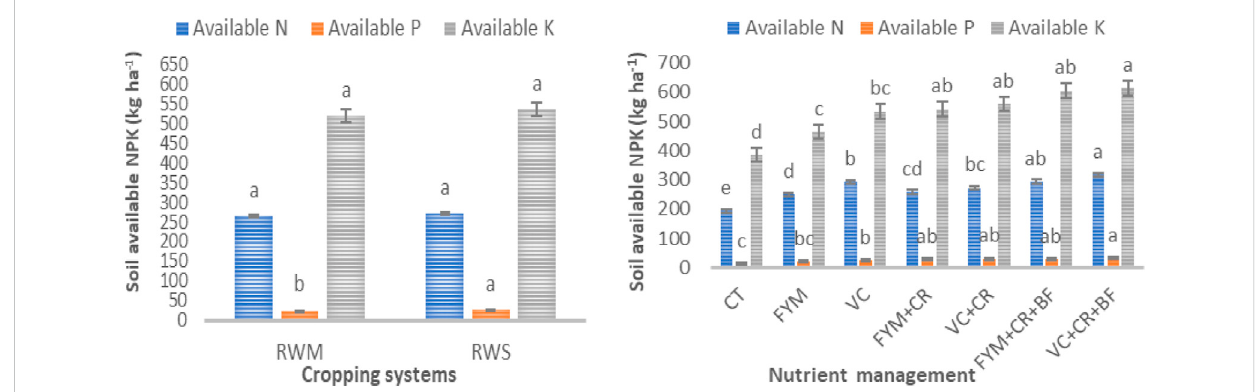
FIGURE 8 Long-term effect of cropping systems and organic nutrient management on soil available N, P, and K. RWM: rice-wheat-mung bean; RWS: rice- wheat-sesbania; CT: control; FYM: farm yard manure; VC: vermicompost; CR: crop residue(s); and BF: biofertilizer(s). Statistical method: analysis of variance for strip-plot design in SAS 9.3 software; n = 42. Values with a different capital letter indicate a signi fi cant difference among the different treatments at p < 0.05 by the LSD test. Bars represent means ± SEM.